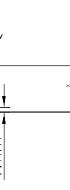
Figure 6. Geometric characterization of the V-groove.